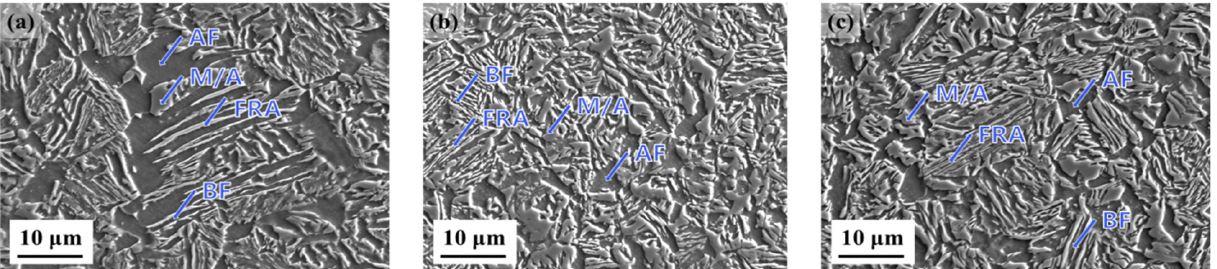
Figure 2. SEM micrographs of the three samples with different cooling rates. ( a ) BS30; ( b ) BS60; ( c ) BS120. Note that AF, M/A, BF, and FRA are allotriomorphic ferrite, blocky retained austenite, bainitic ferrite, and film-like retained austenite, respectively.